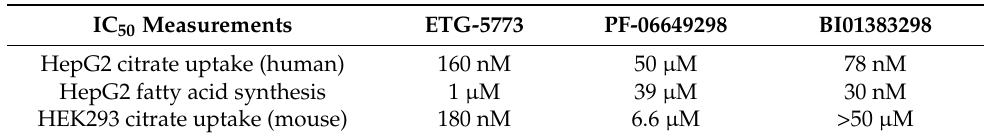
Table 2. Comparison of ETG-5773 with other known inhibitors. Compound structures are shown in Figure